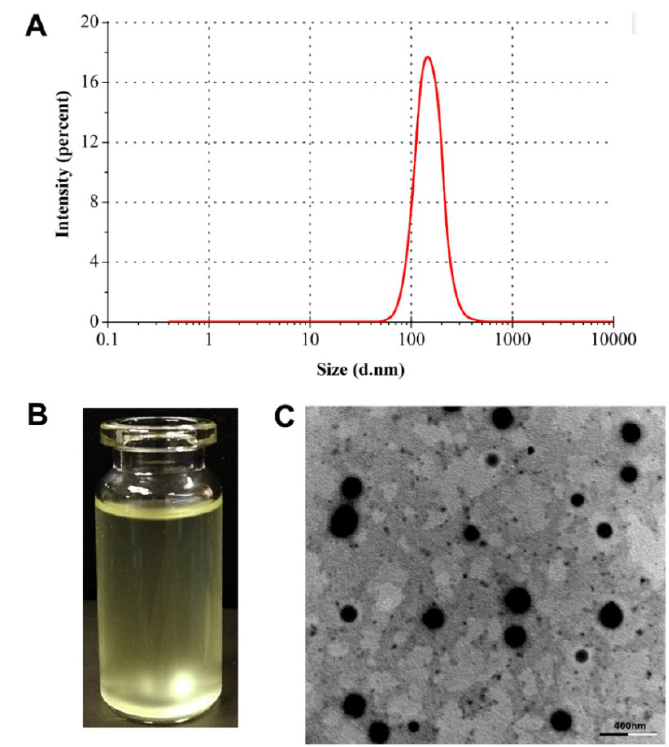
Figure 3. Characterization of RXF-ccNPs: particle size distribution ( A ); appearance ( B ) and TEM micrograph ( C ).